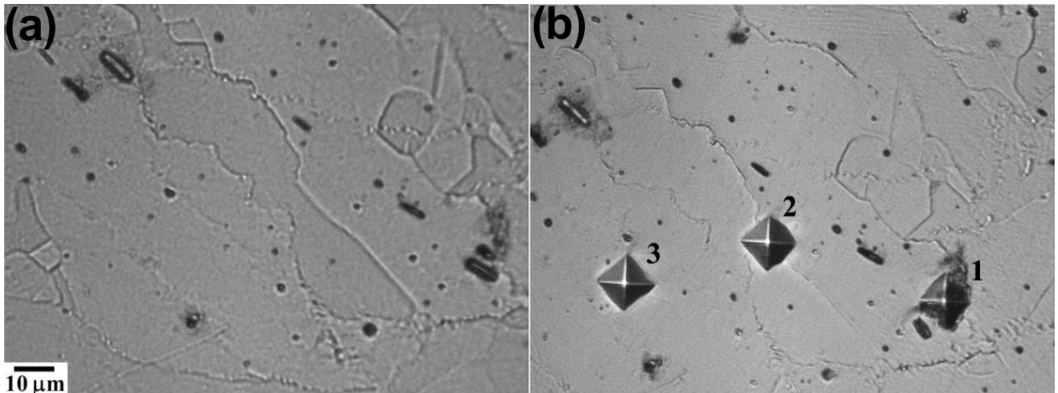
Figure 15. Representative images ( a ) before and ( b ) after microhardness measurements in grain boundaries, large and small particles in a sample of the ISO steel soaked at 1250 ◦ C after two passes with an interpass time of 50 s and quenched immediately after